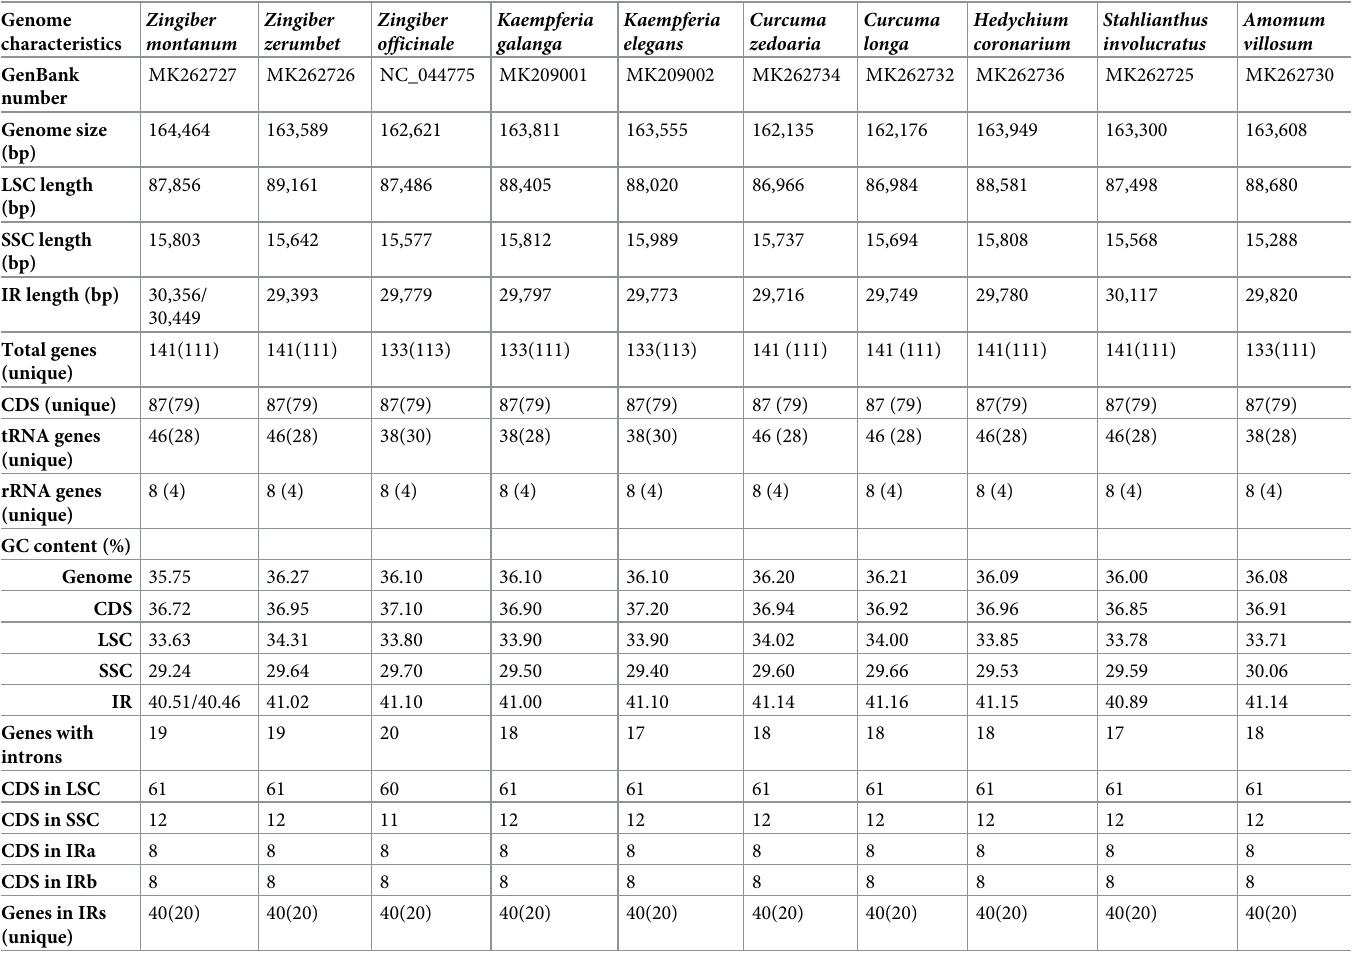
Table 1. Characteristics of the chloroplast genomes of ten Zingiberaceae